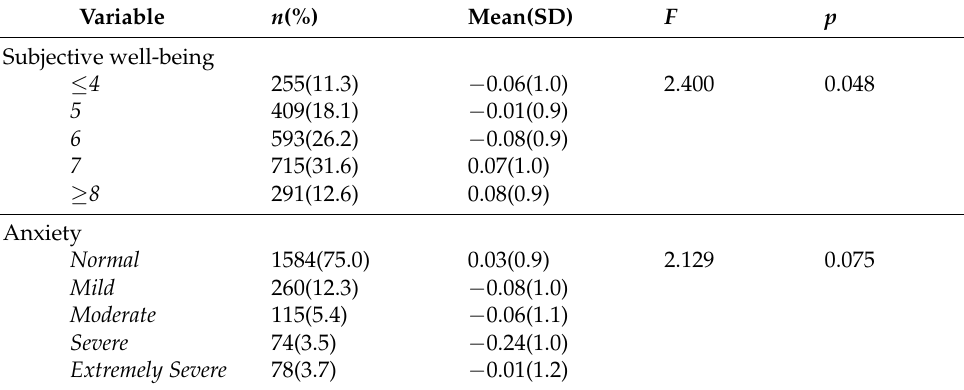
Table 3. Between-group comparisons on the HST index means scores and the psychological